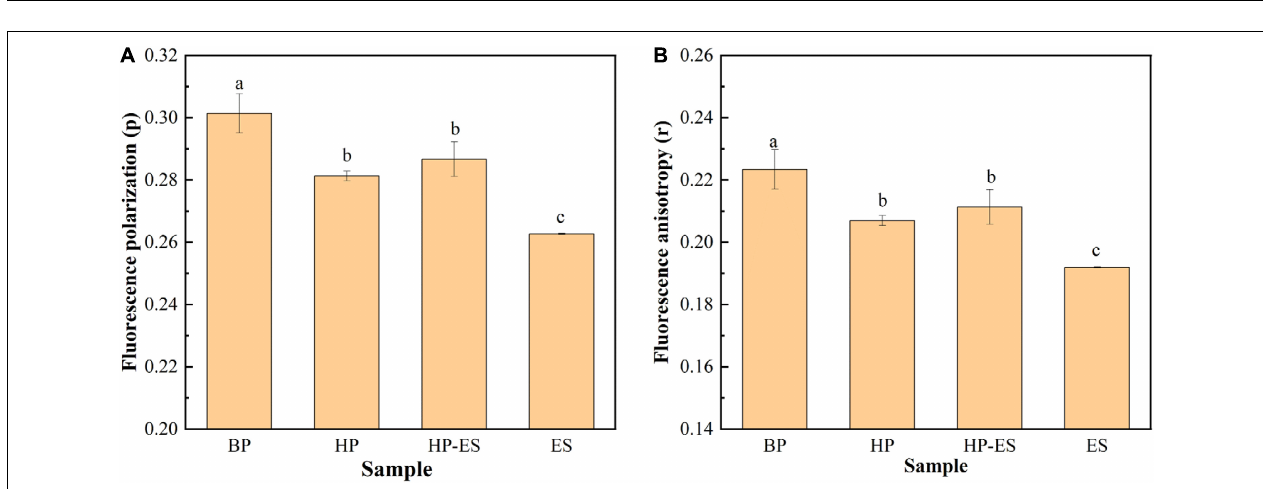
FIGURE 3 | Analysis of membrane fatty acids in T. halophilus under ethanol stress. (A) the distribution of membrane fatty acids; (B) the ratio of un- to saturated fatty acids. BP (before preadaptation): cells harvested at mid-exponential growth phase without any treatment; HP (heat preadaptation): cells were collected after heat preadaptation at 45 ◦ C for 1.5 h; HP-ES (heat preadaptation-ethanol stress): cells were heat preadapted at 45 ◦ C for 1.5 h and then challenged by 10% ethanol stress for 2.5 h; ES (ethanol stress): cells subjected to 10% ethanol stress for 2.5 h without heat preadaptation. Error bars indicate SD ( n = 3). Significant differences among the groups are marked with different letters ( p < 0.05).